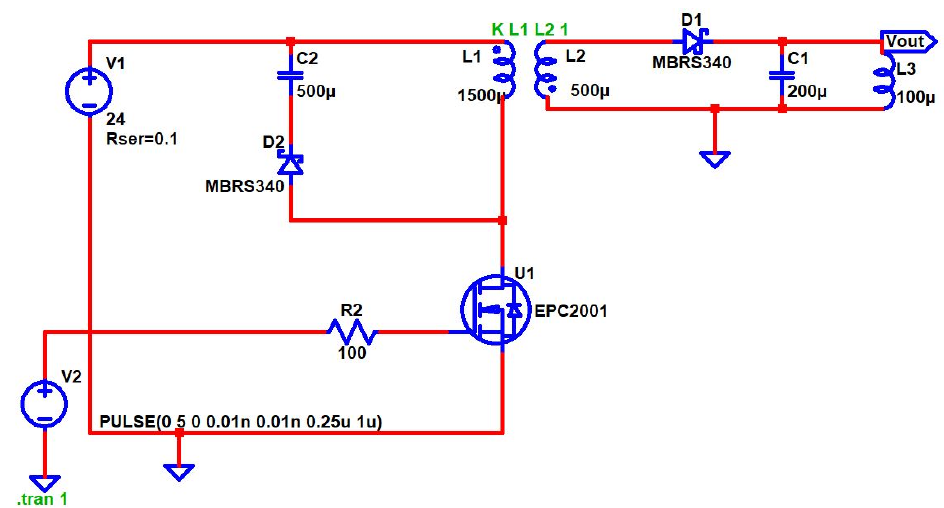
Figure 13. DC-to-DC flyback converter with inductive load configuration.